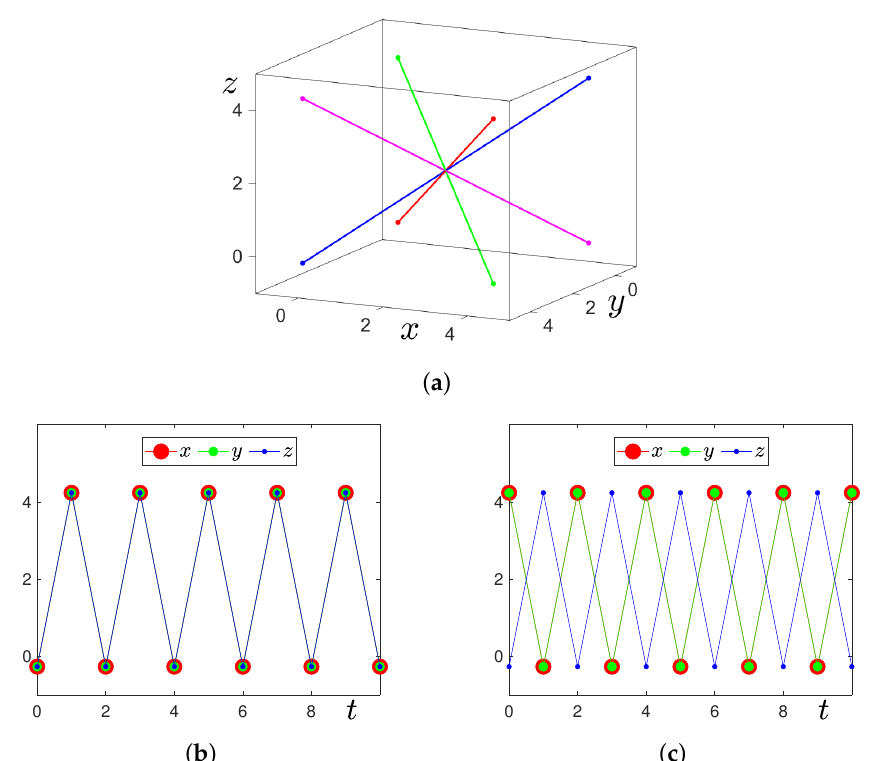
Figure 2. Coexisting 2-cycles in system (1) for σ = 0.2. ( a ) Four coexisting attractors in R 3 . Time series of ( b ) completely synchronized mode ([03]-pattern) and ( c ) partially synchronized mode